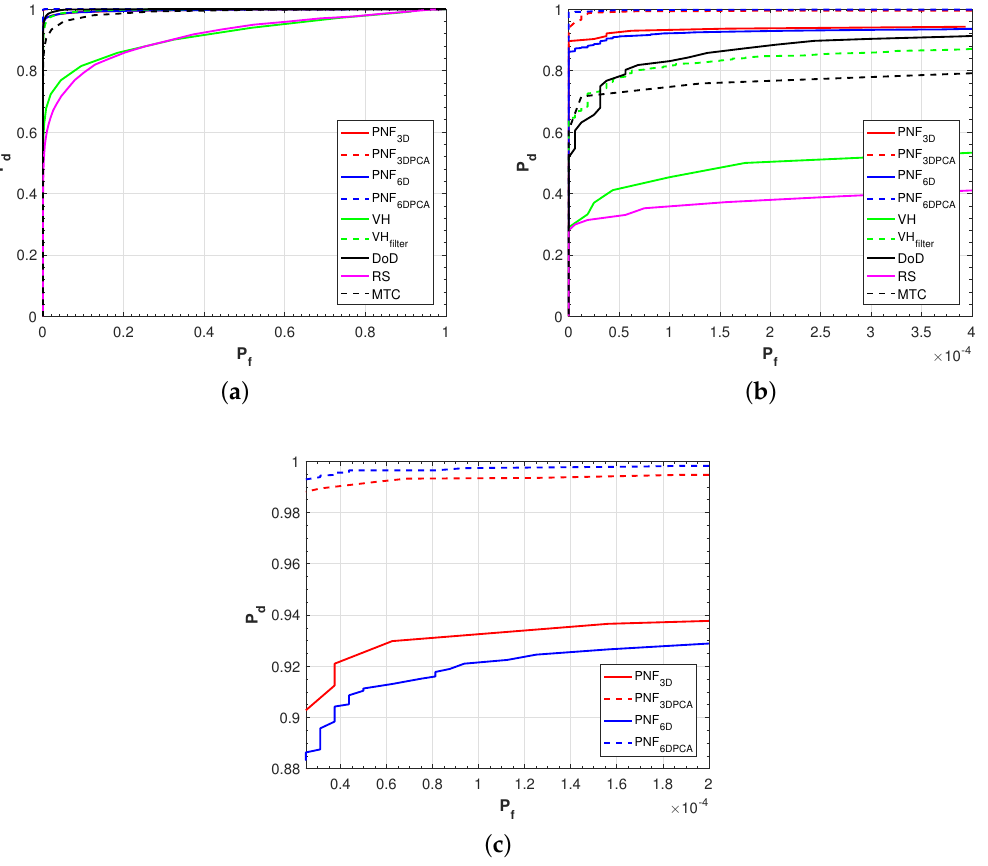
Figure 12. ROC curves. ( a ) the ROC curves ( P f belongs to [0, 1]); ( b ) zoom in on the P f ([5 × 10 − 5 , 10 − 4 ]); ( c ) zoom in on the ROC curves of PNF X